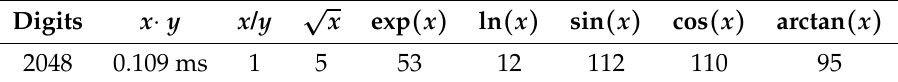
Table 2. Estimation of computational cost of elementary functions computed with Maple 14 and using a processor Intel R (cid:13) Core(TM) i3-2350M CPU, 1.79 GHz (32-bit Machine) Microsoft Windows 7 √ √ 3 − 1 and y = 5. Professional, where x =